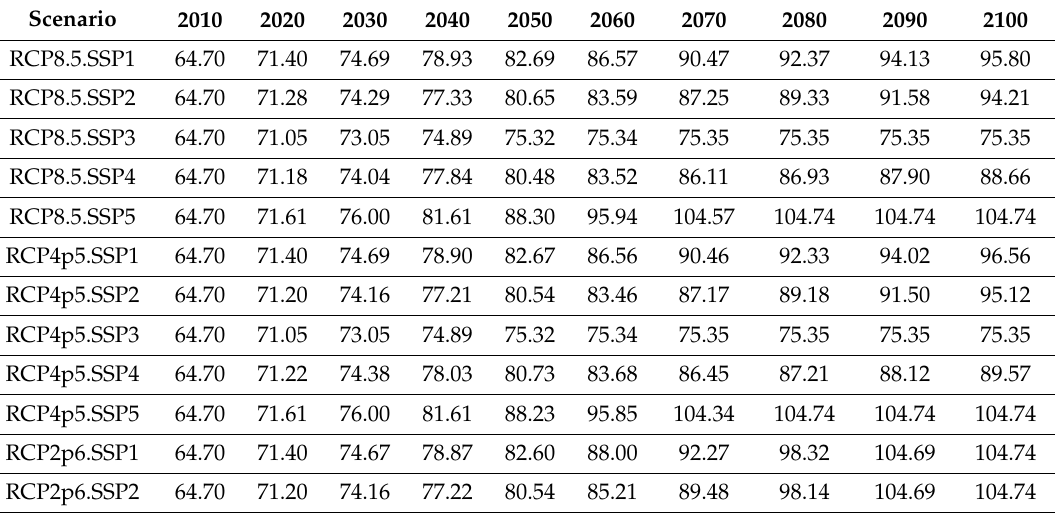
Table A9. Industrial roundwood harvest (millions of m 3 / year, under